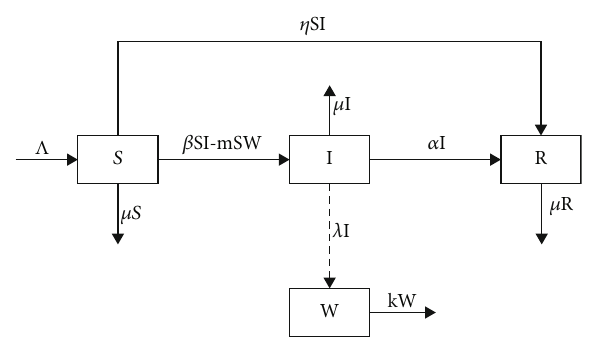
Figure 1: Schematic representation of the rumor spread considering the media e ff